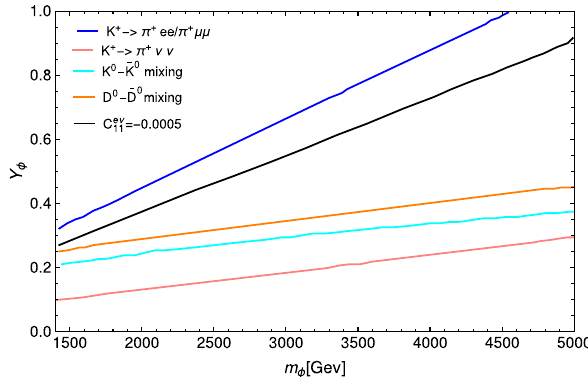
Fig. 16 Constraint on Yukawa coupling of S 3 as a function of its mass describing R K ( ∗ ) anomalies [15]. The yellow and green colours indicate 1 σ and 2 σ allowed regions